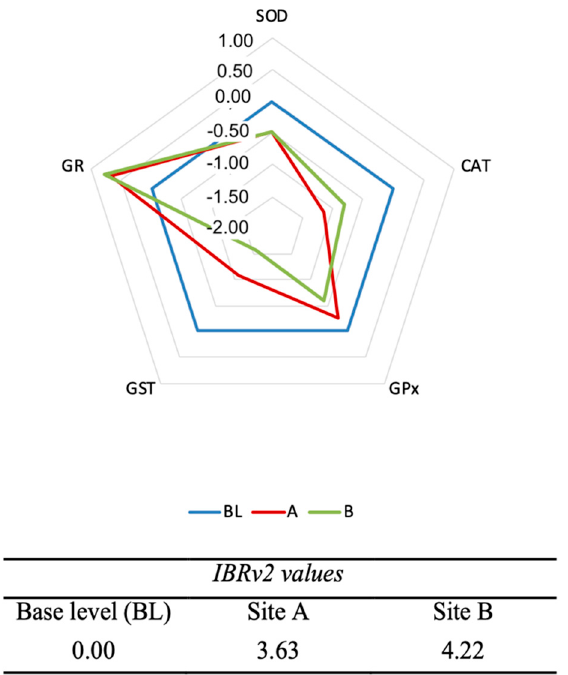
Figure 4. Star plot and IBRv2 values in epithelioma papulosum cyprini (EPC) cell line exposed to concentrated drinking water from sites A and B. CAT denotes catalase, GPx glutathione peroxidase, GR glutathione reductase, GST glutathione S-transferase, SOD superoxide dismutase.